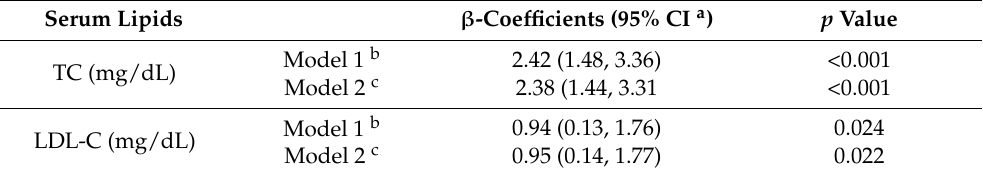
Table 3. Odds ratios of serum lipids by urine arsenic concentrations. 70th Versus 30th Percentile Urinary total arsenic ( µ g/L) 14.40/4.70 22.00/3.49 Model 1 a 1.17 (1.02, 1.35) TC Model 2 b Model 3 LDL-C